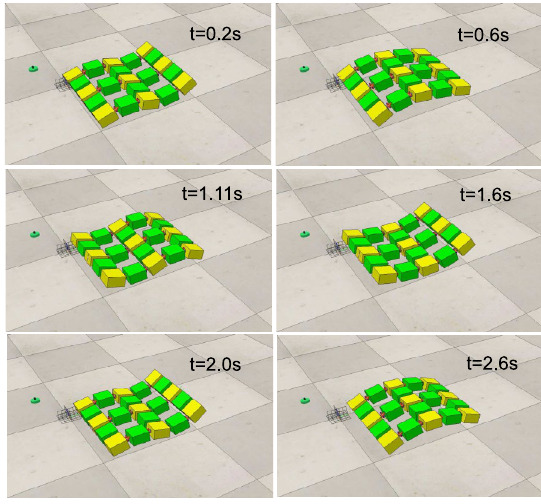
Fig. 12 Translational locomotion of WORMESH-II for IMF in the simulation (wave parameters are A = 0.05 π , ω = 0.5 π , and β = 4 π/ 3